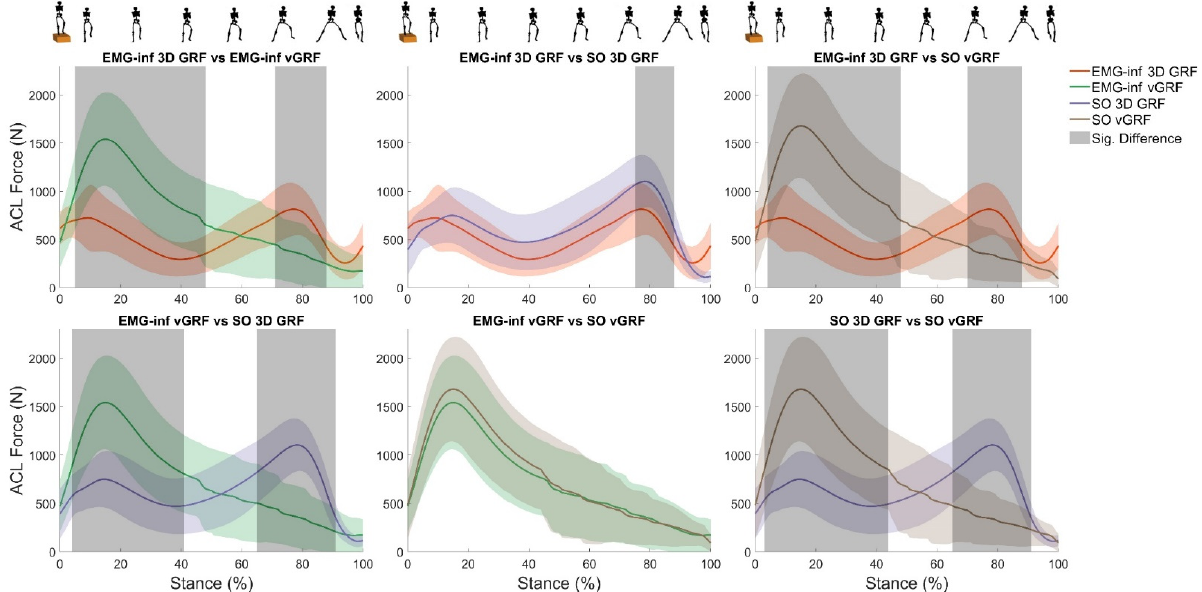
Figure 2. Pairwise comparisons of total ACL force (±1 standard deviation) over the stance of the barefoot drop–land–jump estimated via four modelling approaches: EMG-informed + 3D GRF (red line); Static optimisation + 3D GRF (purple line); EMG-informed + vertical GRF (green line); Static Optimisation + vertical GRF (brown line). Grey-shaded regions display statistical differences using a paired t-test applied through Statistical Parametric Mapping. vGRF, vertical ground reaction force; EMG-inf, EMG-informed; SO, static